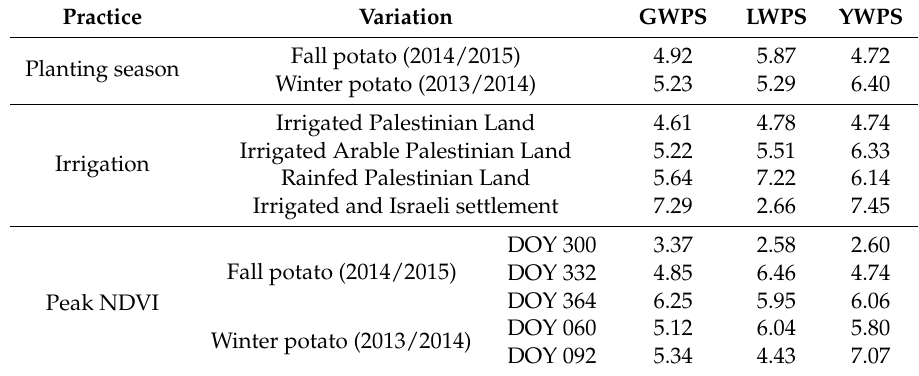
Table 5. Mean CWP scores for different management practices using different sub-indicators. Practice